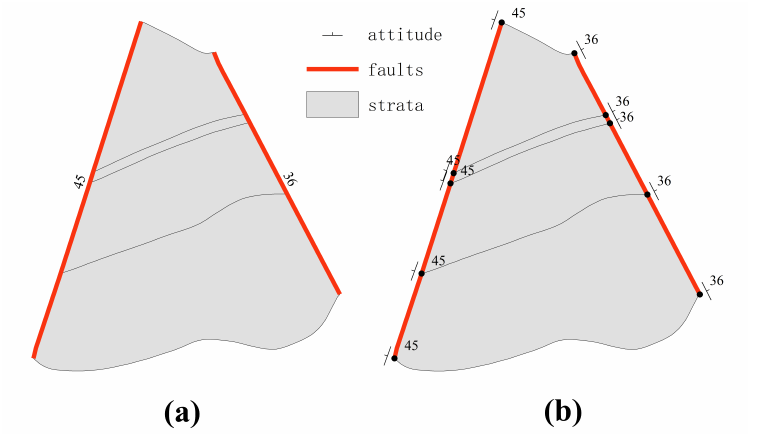
Figure 4. Schematic diagram of conduction of the boundary points’ attitude on the fault: ( a ) attitude of faults; ( b ) attitude of stratigraphic boundary